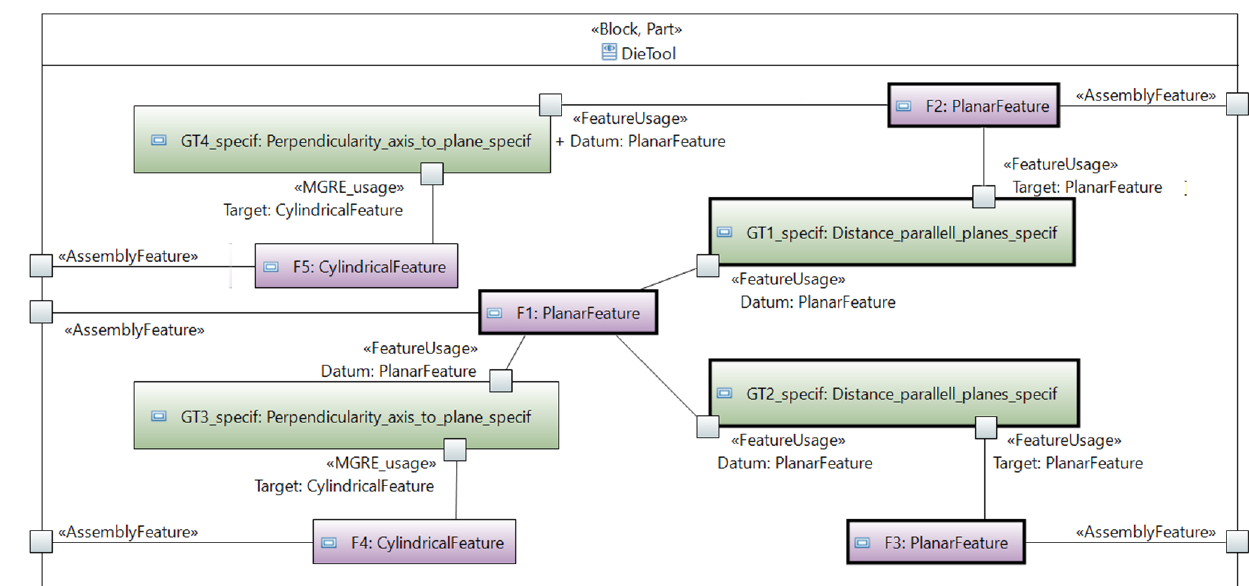
Figure 16. IBD to represent the Feature ‐ based internal structure of the DieTool Block.